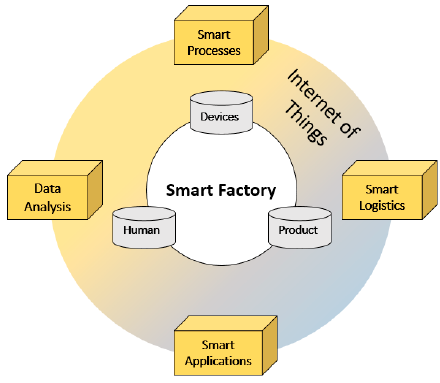
Figure 4. The main elements of a Smart Factory.